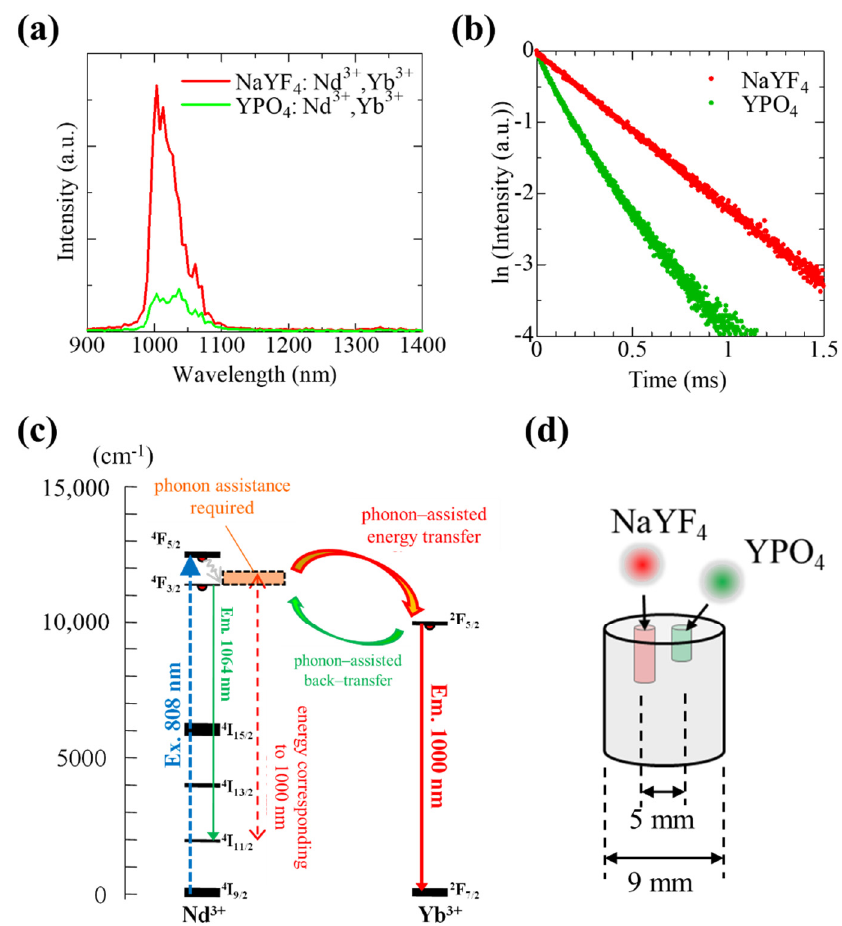
Figure 2. Optical properties of YPO 4 and NaYF 4 co-doped with Nd 3+ and Yb 3+ . ( a ) Emission spectra of NIRF of Yb 3+ ( 4 F 5/2 → 4 F 7/2 ) from NaYF 4 : Nd 3+ , Yb 3+ and YPO 4 : Nd 3+ , Yb 3+ . ( b ) Fluorescence decay curves of NaYF 4 : Nd 3+ , Yb 3+ (fluorescence lifetime: 470 µ s) and YPO 4 : Nd 3+ , Yb 3+ (240 µ s) detected using a photomultiplier tube. ( c ) Energy diagram of ceramic particles co-doped with Nd 3+ and Yb 3+ , which was used as the sensitizer excited by an 808 nm laser and as a 1000 nm emitter. ( d ) Schematic illustration of the sample from which the data in Figures 3 and 4 were obtained. NaYF 4 : Nd 3+ , Yb 3+ (470 μ s) and YPO 4 : Nd 3+ , Yb 3+ (240 μ s) were embedded in an agar gel as a model of water-containing tissue.